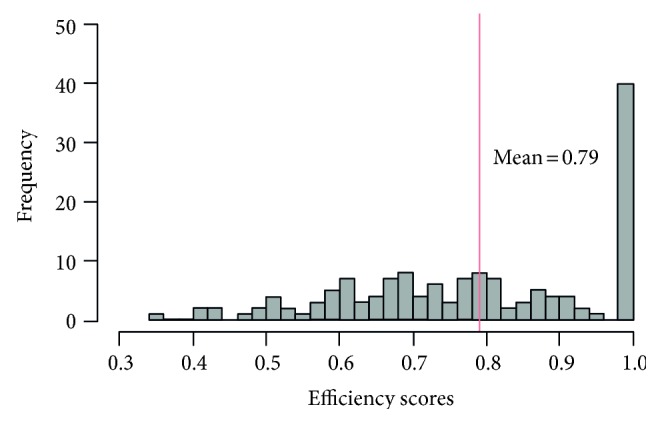
Distribution of DEA scores.